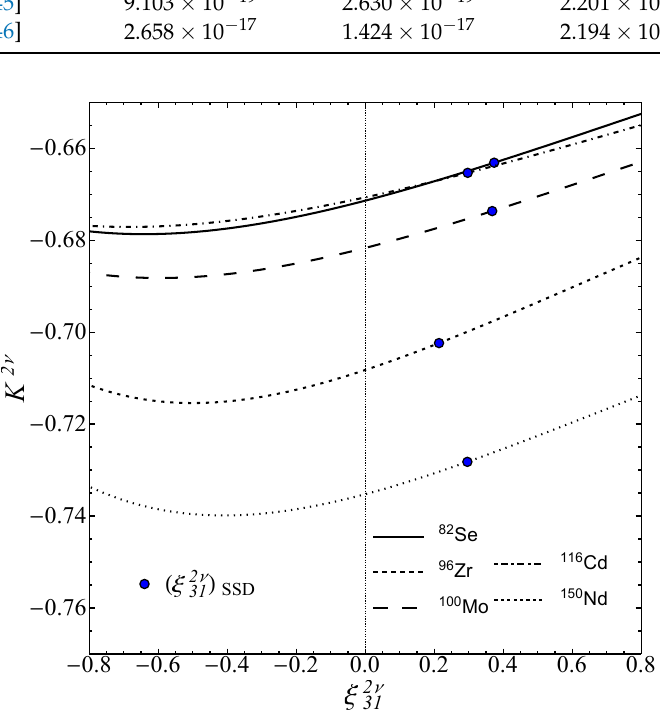
Figure 2. The angular correlation coefficient between the electrons emitted in 2 νββ decay of 82 Se, 96 Zr, 100 Mo, 116 Cd, and 150 Nd, as functions of ξ 2 ν for the ratio of the nuclear matrix elements fixed by the SSD assumption, 82 Se and 116 Cd, the right filled circle correspond to 82 Se and the left one to 116 Cd. We used the approximation scheme C for the relativistic wave function of the emitted